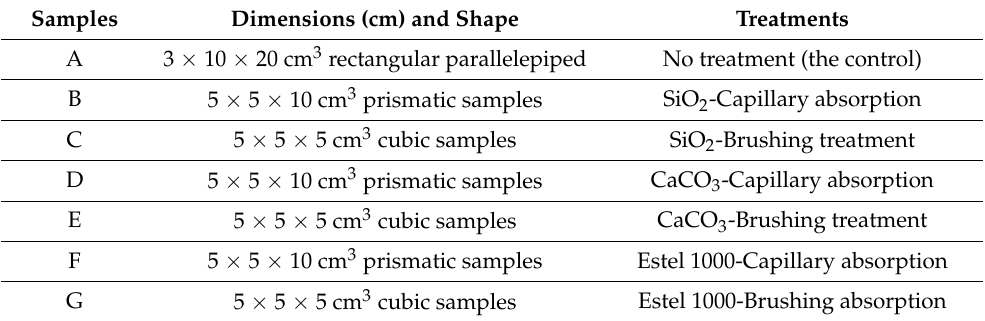
Table 3. Sample dimensions, shape, and applied treatments.